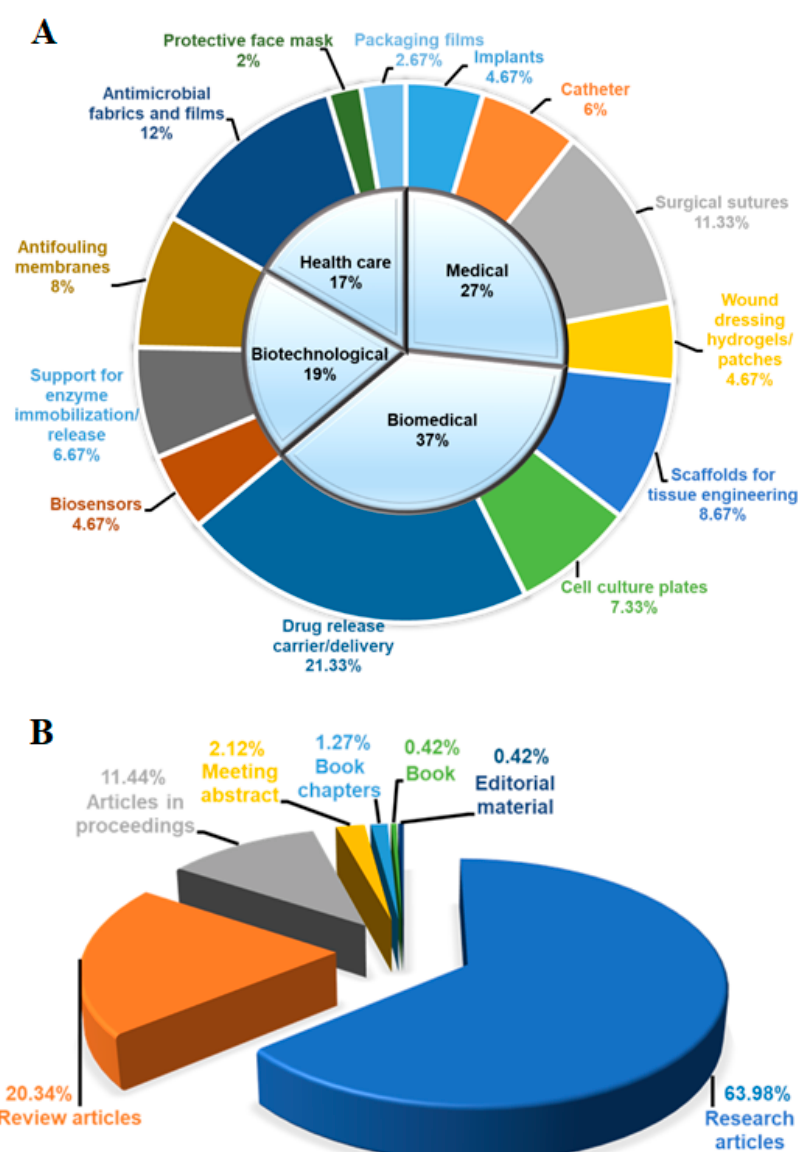
Figure 4. Graphical representation of: ( A ) various applications % of FPBMs with bioactive properties prepared by RIGC and ( B ) distribution % of their related publications. Total number of records is 235.